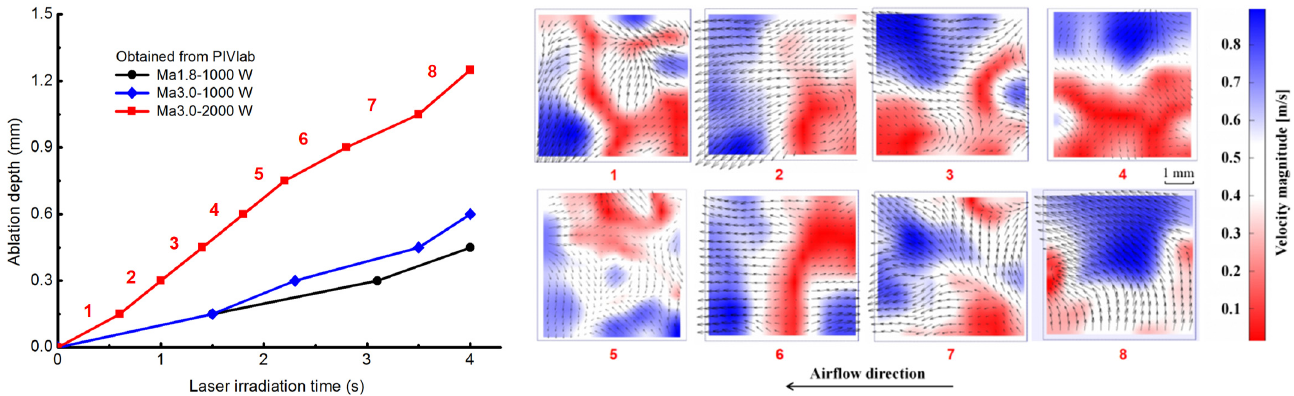
Figure 7. Instantaneous surface recession depths of different experimental conditions are obtained by PIVlab analysis.